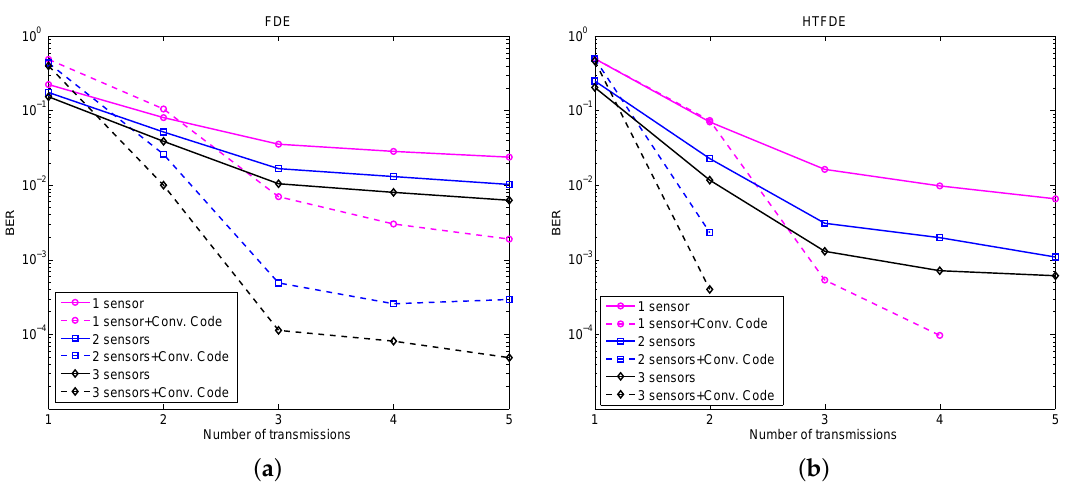
Figure 9. BER performances as a function of the number of transmissions and the number of elements used: ( a ) the performance with MRC-FDE and convolution code and ( b ) the performance with MRC-HTFDE and convolution code.